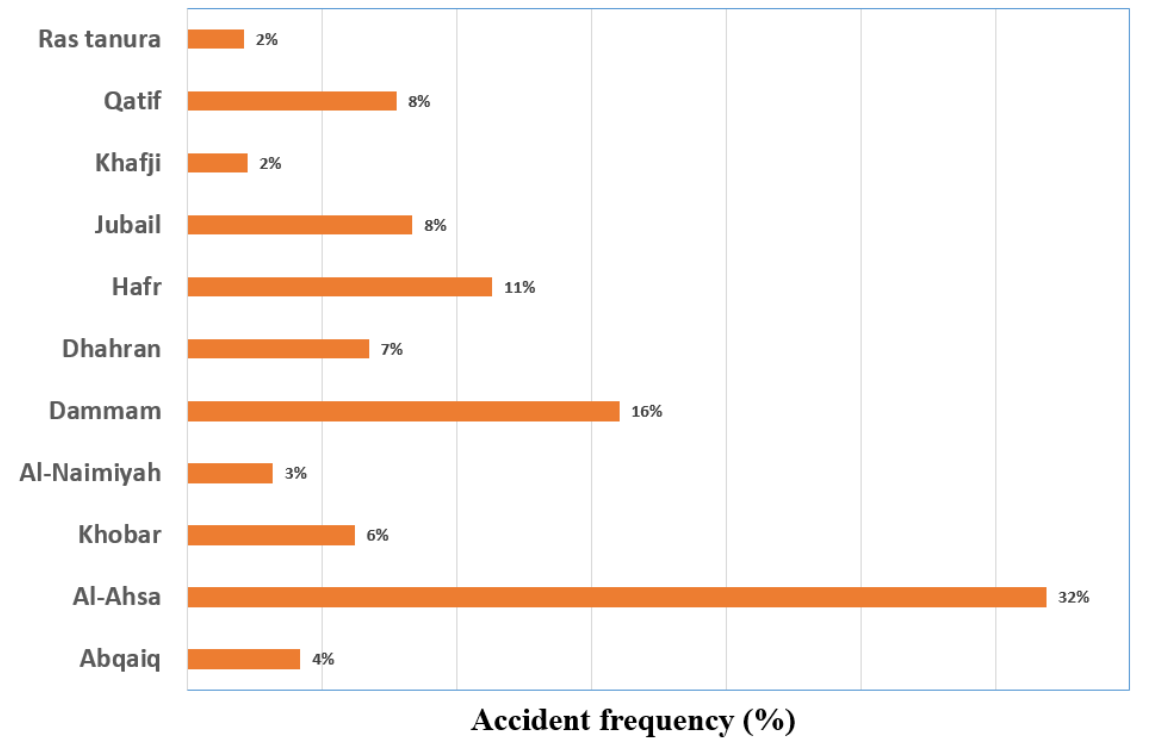
Figure 2. Frequency of road crashes in different cities in the Eastern region of Saudi Arabia (adopted from [62]).